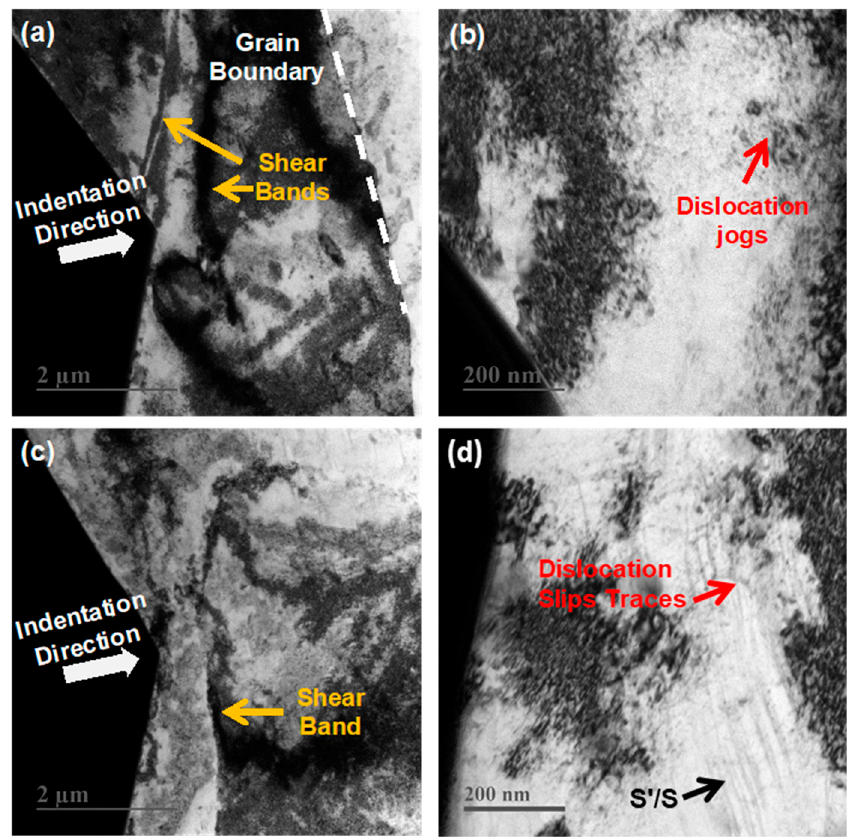
Figure 8. TEM micrographs of lamellae extracted from the indentation imprints of AA2524. ( a ), ( b ) Pre-aged 0 h specimen and local magnification; ( c ), ( d ) Pre-aged 12 h specimen and local magnification.